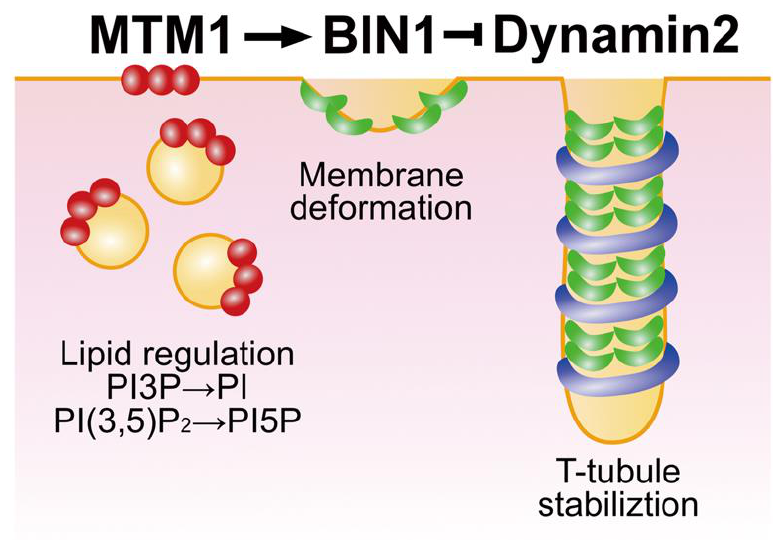
Figure 1. Functions of MTM1, BIN1 and DNM2 in T-tubule biogenesis. CNM causative genes MTM1, BIN1 and DNM2 contribute to T-tubule biogenesis in a common pathway by respectively regulating lipid homeostasis, membrane deformation and T-tubule stabilisation.